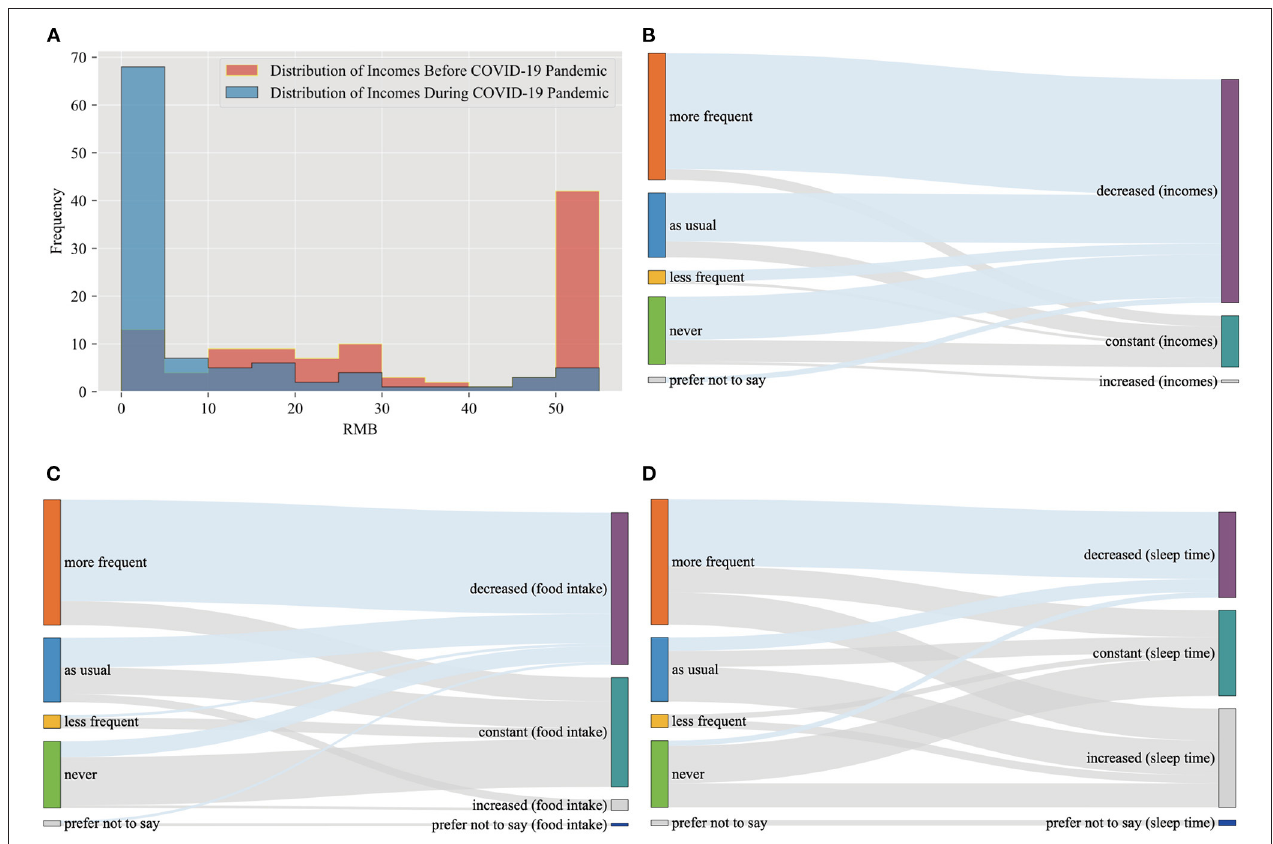
FIGURE 3 | (A) The distribution of incomes before and during the COVID-19 pandemic; (B) the relationships between income changes and the frequency of being driven off; (C) the relationships between food intake changes and the frequency of being driven off; (D) the relationships between sleep time changes and the frequency of being driven